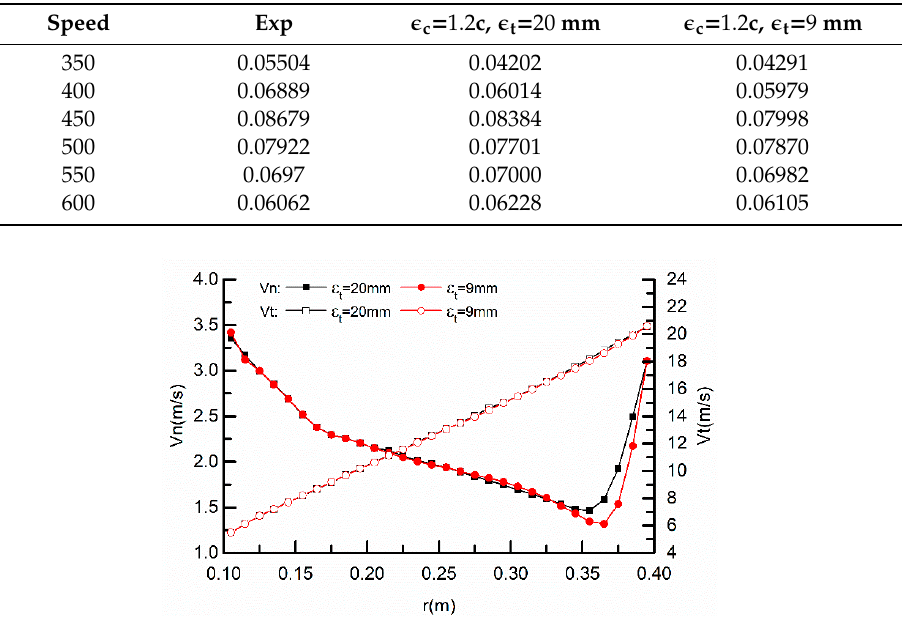
Figure 15. The V n and V t of each blade element along the blade when rotating speed is 500 RPM calculated by di ff erent (cid:15) t value.